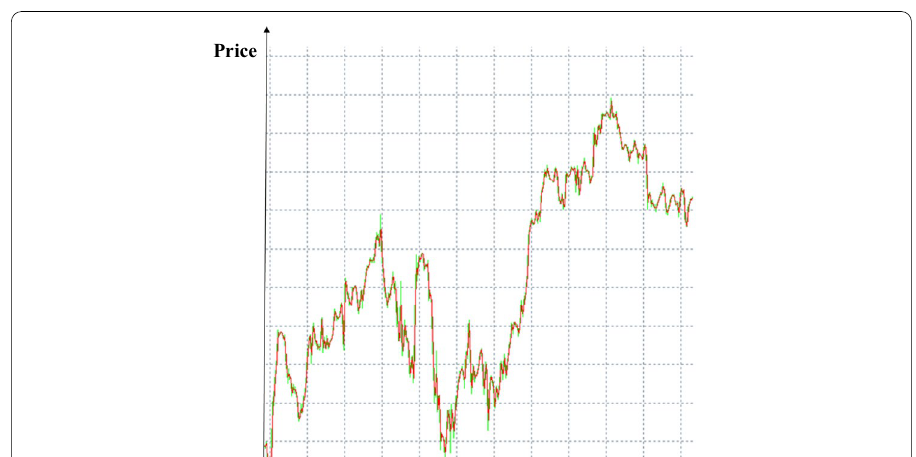
Fig. 4 Error curve